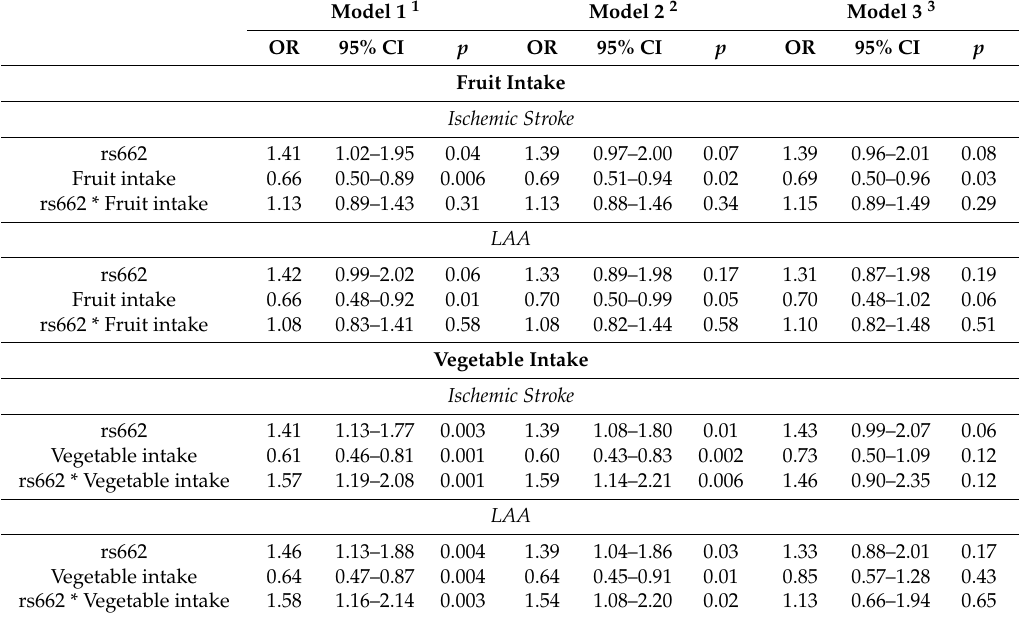
Table 3. Interaction between PON1 rs662_G allele numbers and standardized fruit and vegetable intake for total ischemic stroke and LAA.